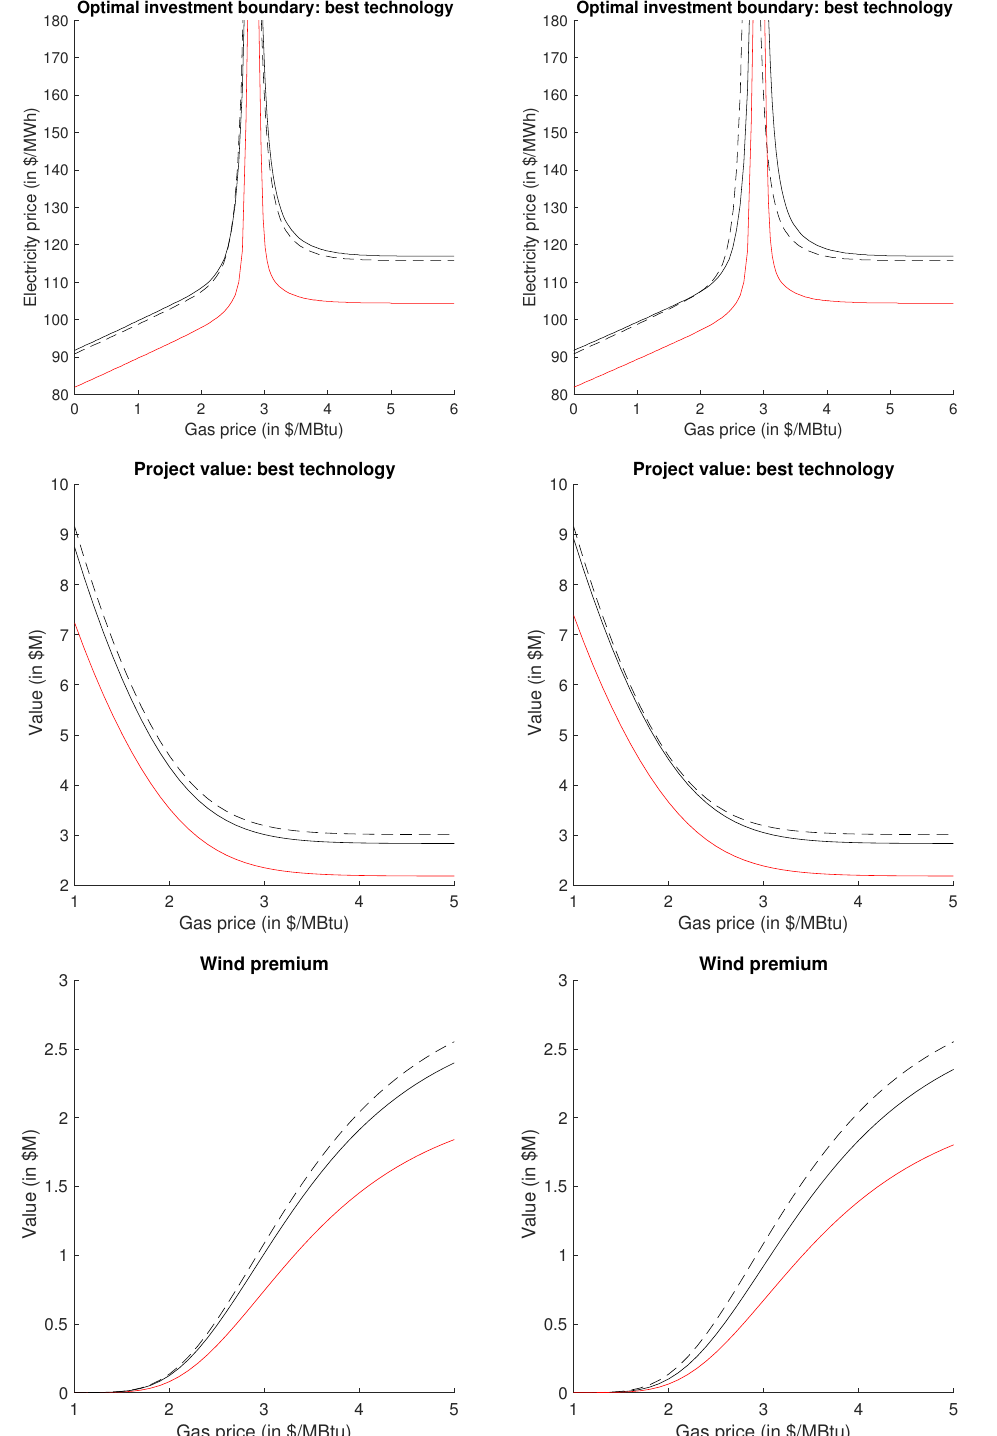
Figure 15. This figure displays the effects of the interest rate r on the investment boundaries (upper panels), project value (middle panels) and wind premium (lower panels) at t = 0 in case of low sensitivity of the gas price ( C = 0, left panels) and of high sensitivity ( C = 2.5, right panels). The value of X 0 is 50$/MWh. The values of r are: r = 0.04 (black solid) and r = 0.01 (red). The black dashed line corresponds to the no-pandemic cases with r = 0.04. Other parameter values are given in Table 1; the investment horizon is T = 1